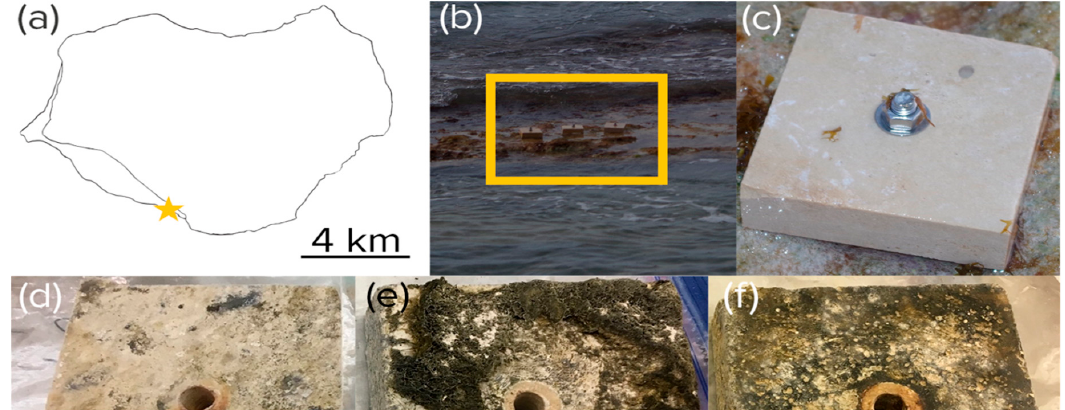
Figure 1. Experimental tile placement. ( a ) Location near Playa Uvero (yellow star) on Isla de Mona, Puerto Rico. ( b ) Anchoring on a stretch of intertidal beach rock (yellow box) as seen at low tide. ( c – f ) Aspect of virgin ( c ) and exposed tiles harvested after harvested after 3 ( d ), 6 ( e ), and 9 months ( f ). Part of the growth observable in the pictures was epilithic in nature.